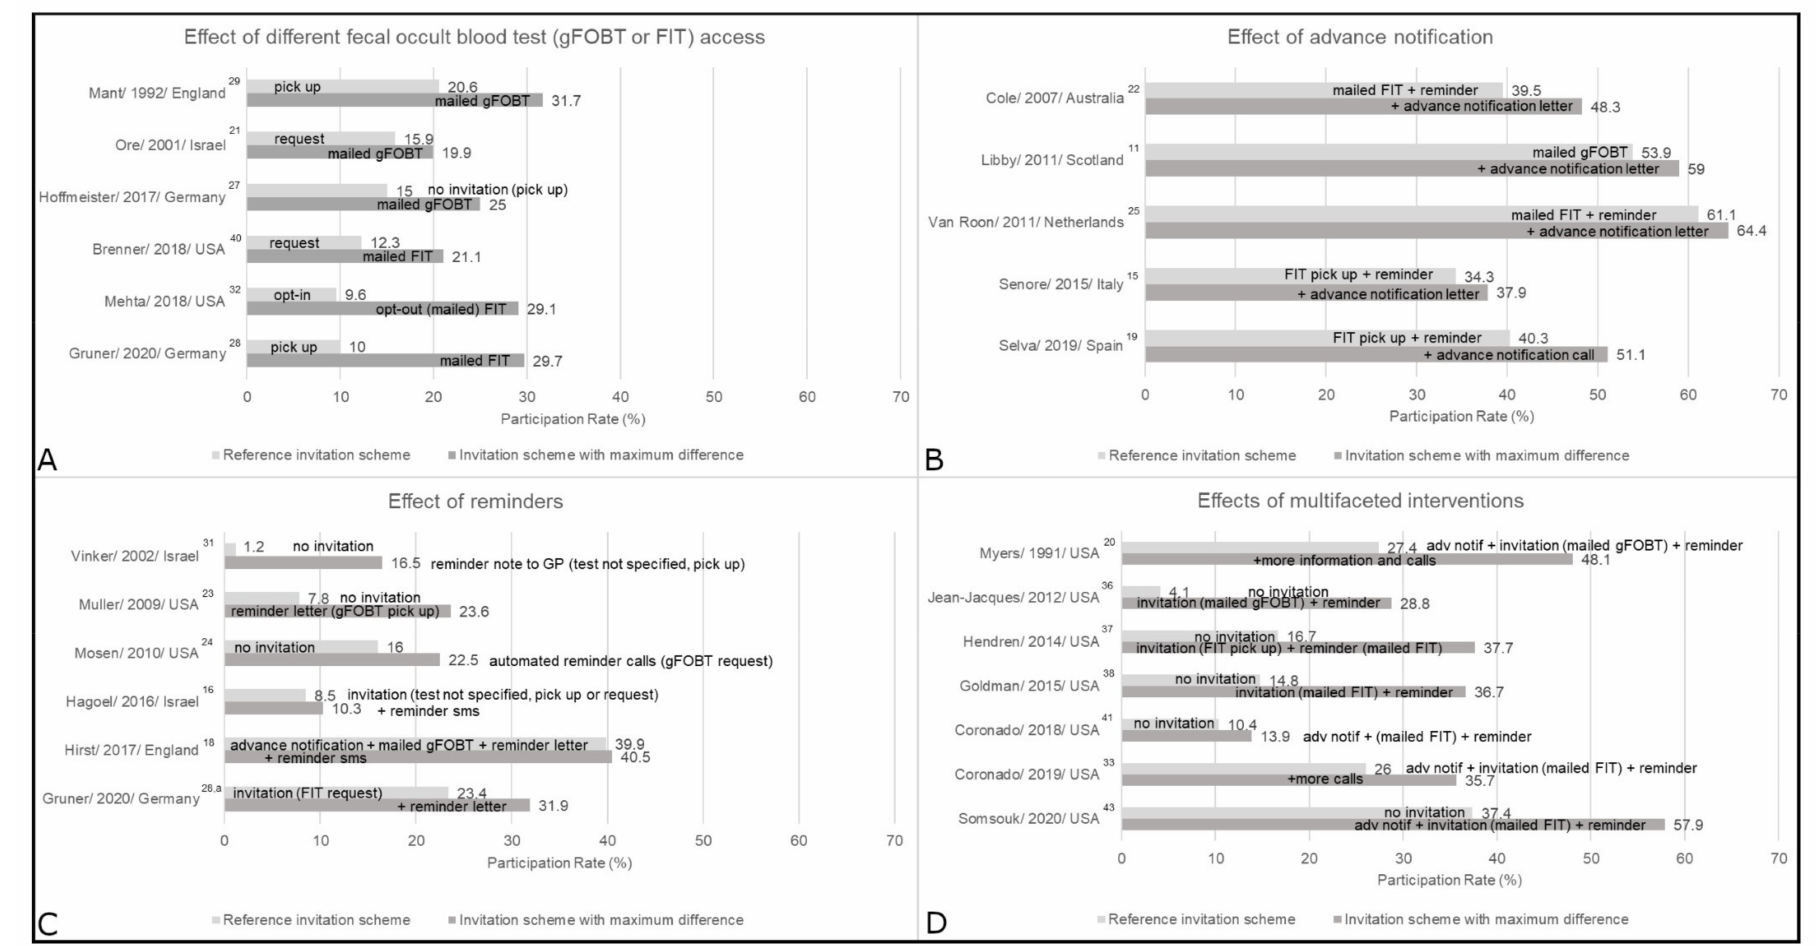
Figure 2. Main results by intervention approach: ( A ) fecal occult blood test (gFOBT or FIT) access, ( B ) advance notification, ( C ) reminders, and ( D ) multifaceted interventions. This figure shows the reference group and the group with the biggest difference, groups in between were dropped. a Randomized sub-study. adv notif = advance notification; FIT = fecal immunochemical test; gFOBT = guaiac-based fecal occult blood test; GP = general practitioner; sms = text